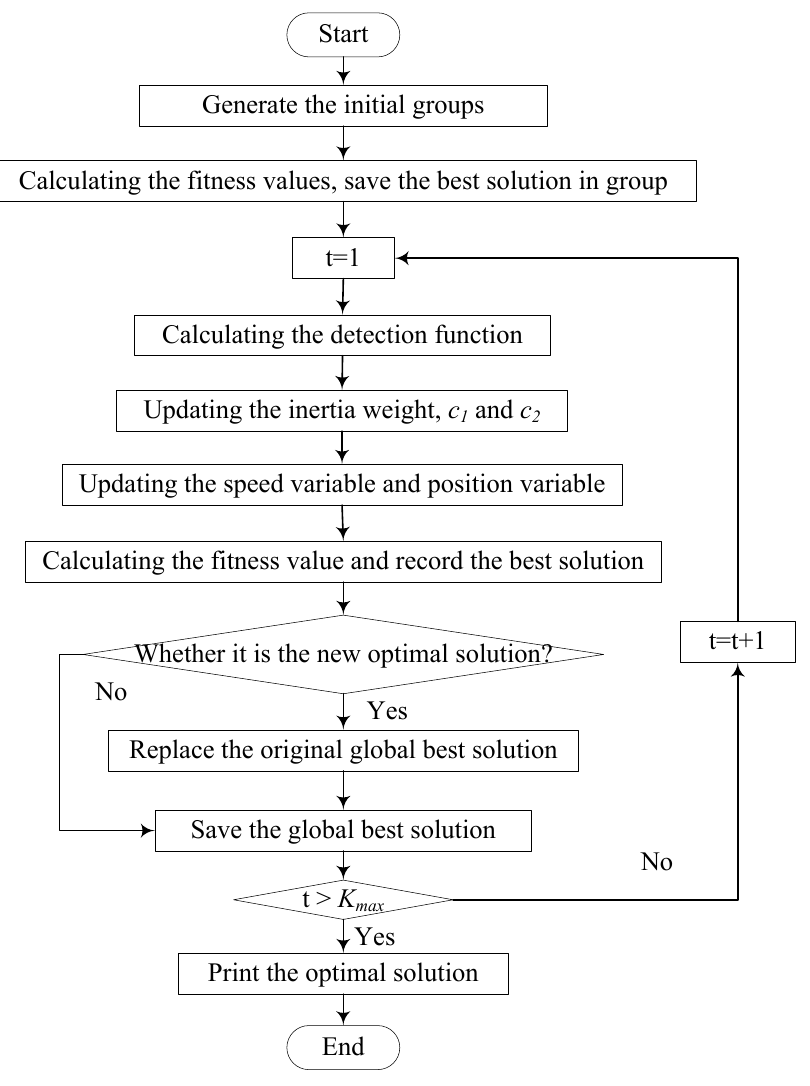
Figure 4. The flow chart of the improved PSO